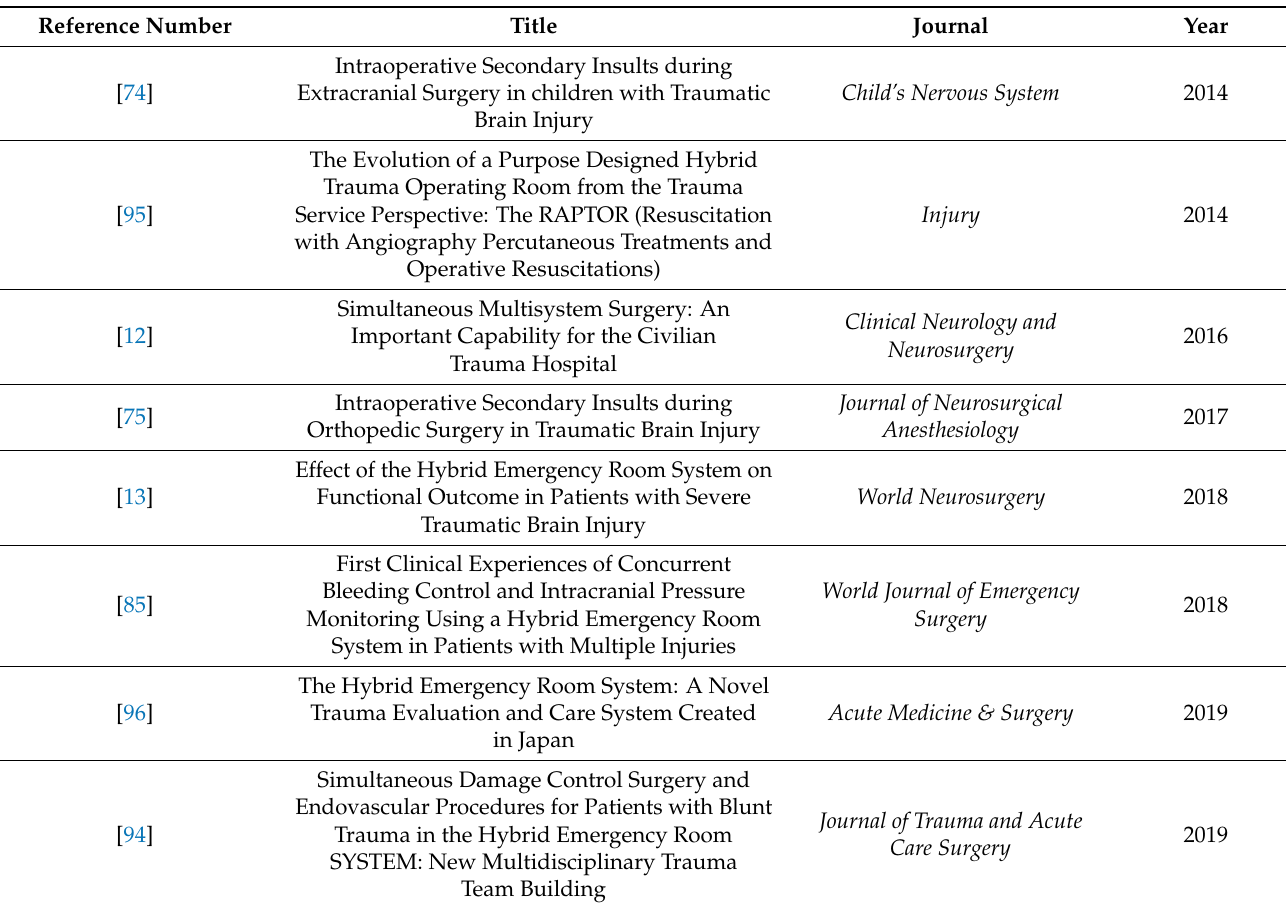
Table 1. Relevant studies regarding polytrauma TBI